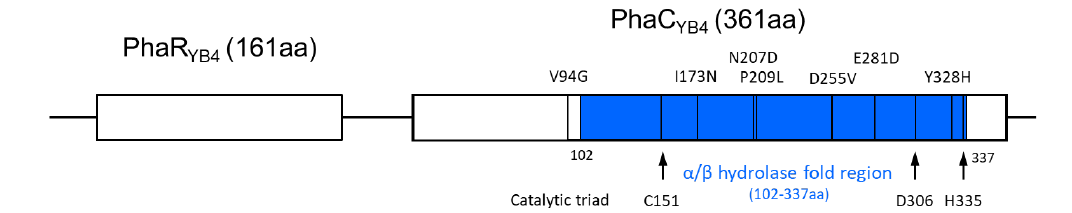
Figure 4. Important mutation on PhaRC YB4 to increase the molecular weight. The positions of catalytic triad are shown by arrows. The single mutations of E281D and Y328H did not affect the PHA molecular weight but function synergistically with I173N and P209L, respectively (see Section 3.3).